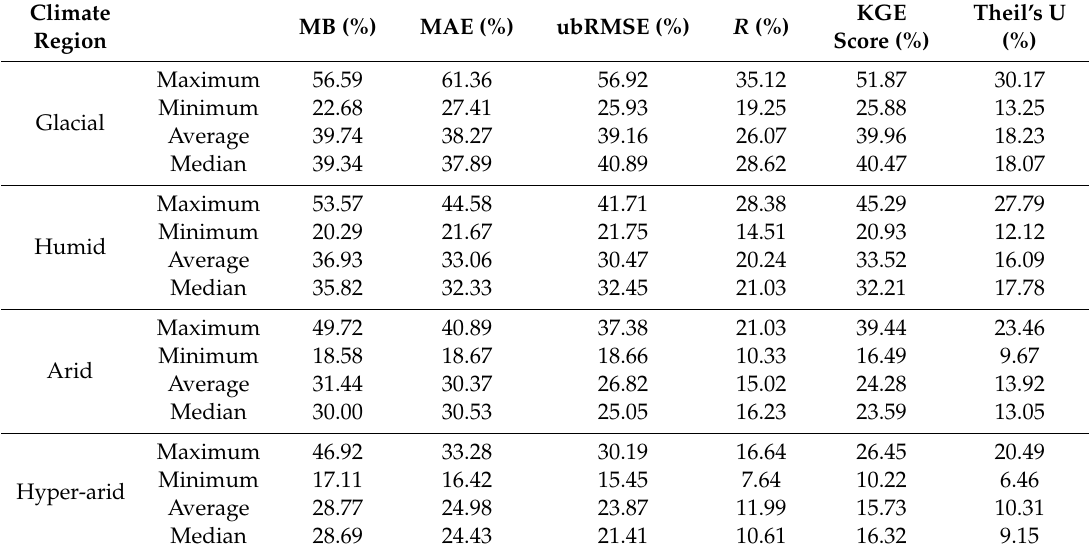
Table 9. Comparison of WALS-RBPD performance with the blended precipitation dataset based on dynamic Bayesian model averaging (DBMA-BPD) using skill score during a common period of